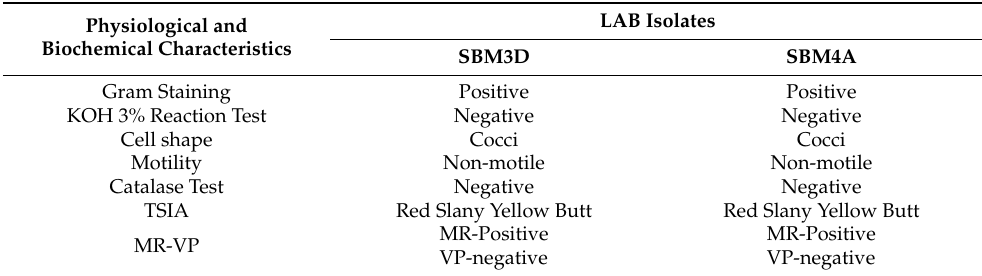
Table 1. Physiological and biochemical properties of the LAB isolated from fermented Wakawondu rice washing